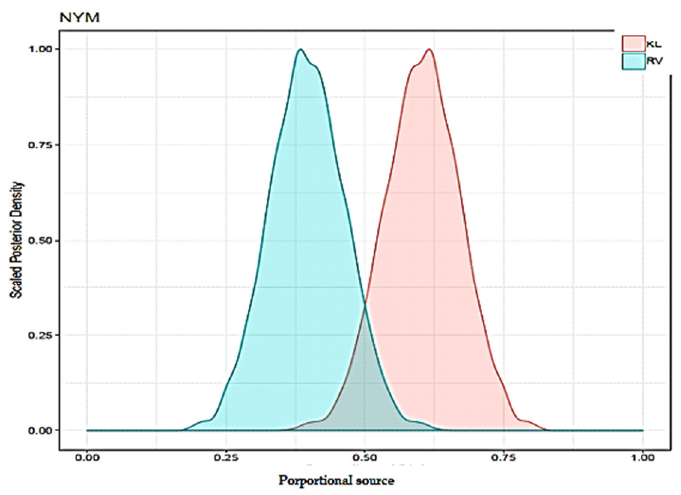
Figure 6. Sediment source apportionment using MixSIAR, where KL accounted with 60.3% and RV with 39.7%.